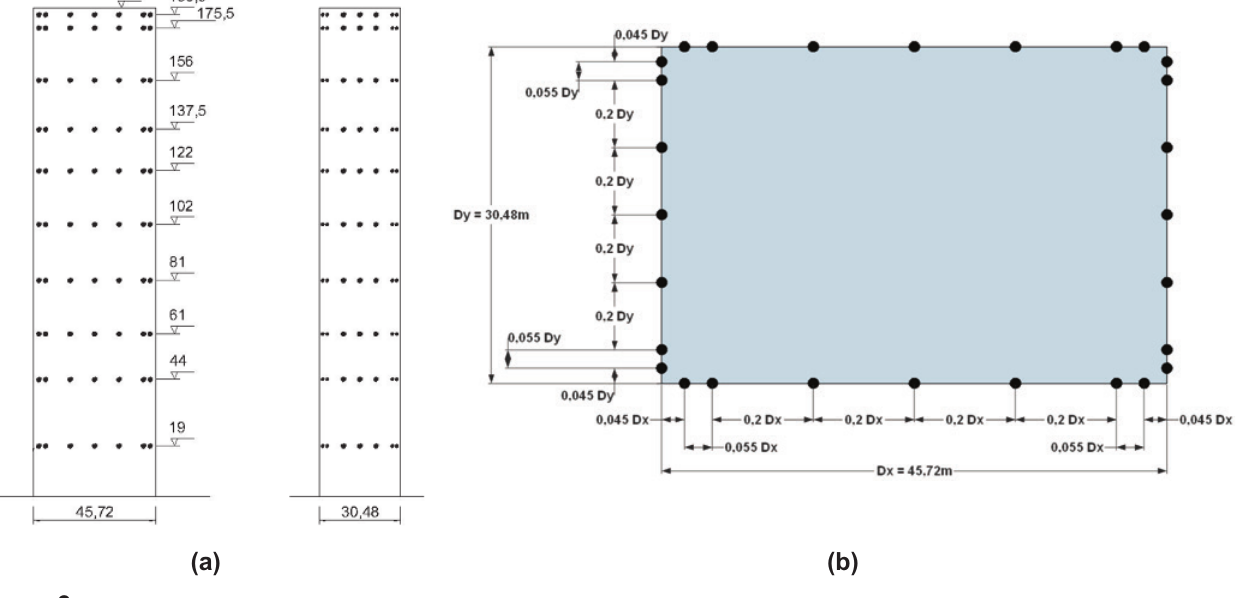
model and the models used as neighboring buildings, presented in Figure 2, measures 75mm x 112mm x 450mm. The study model was built in acrylic, equipped with 280 pressure plugs distributed on the four facades and divided in ten height levels, as shown on Figure 3. The plugs contain the standard location as established by [12], and on regions next to the edges where there are high pres - sure gradients, as adopted by [13]. The pressure data of each plug where obtained through a micro